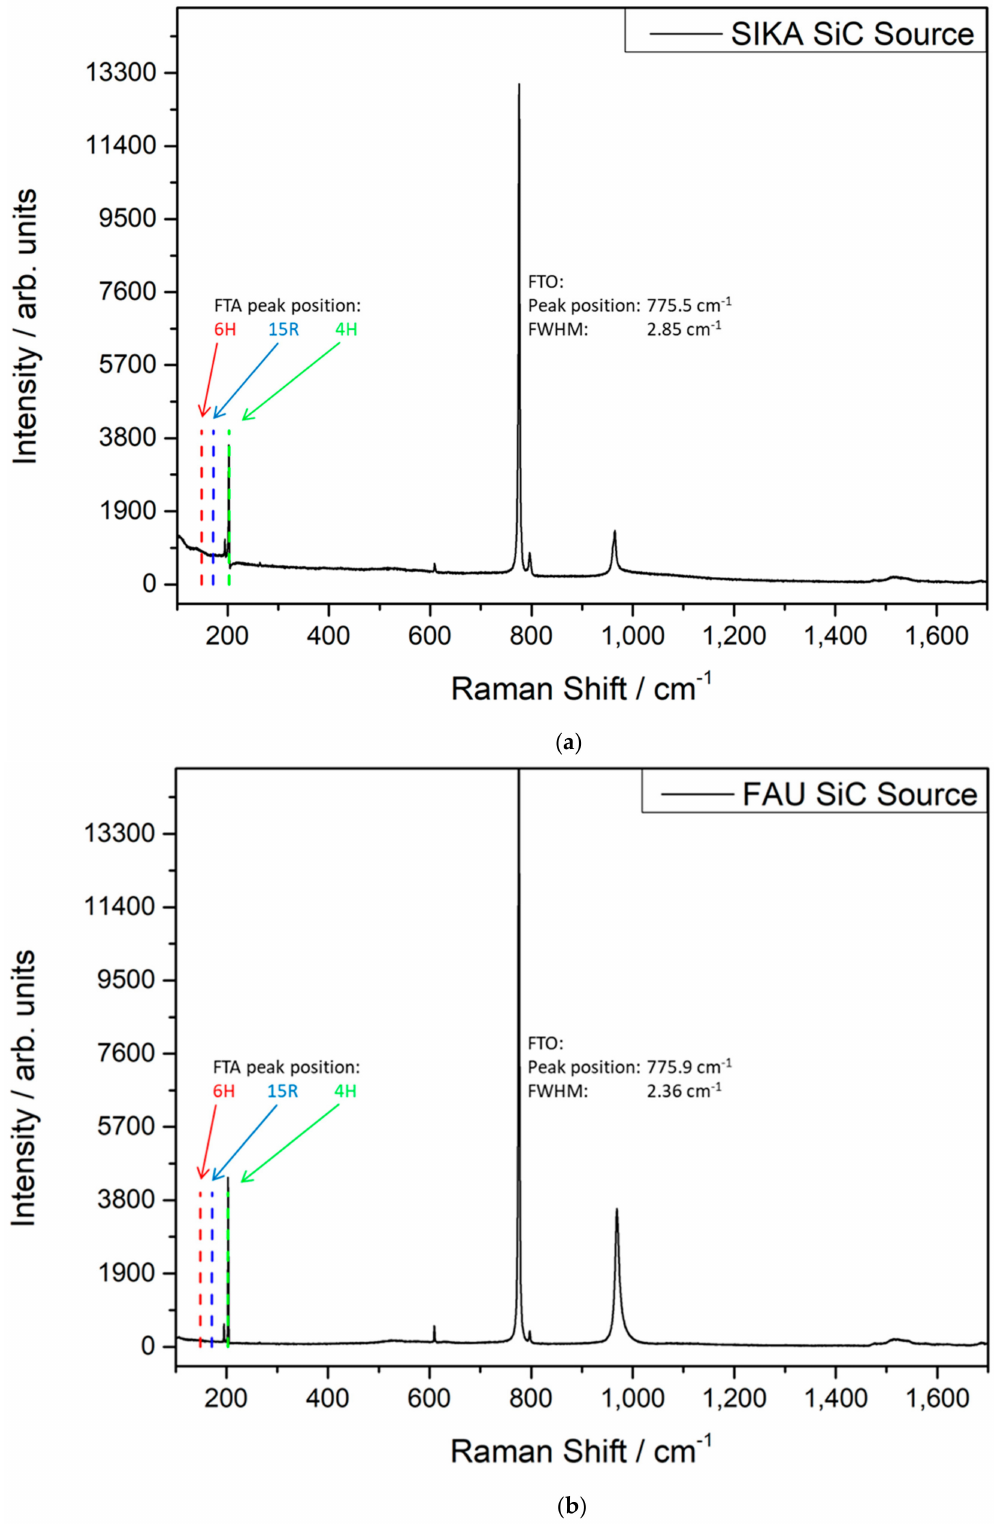
Figure 4. Raman spectra of wafers of the 75 mm SiC crystals grown with ( a ) the new SIKA and ( b ) the the FAU reference SiC